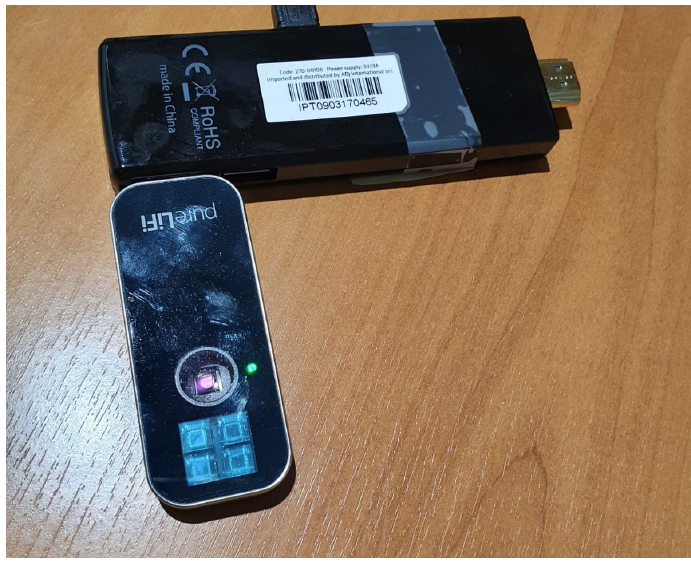
Figure 2. Mobile device.